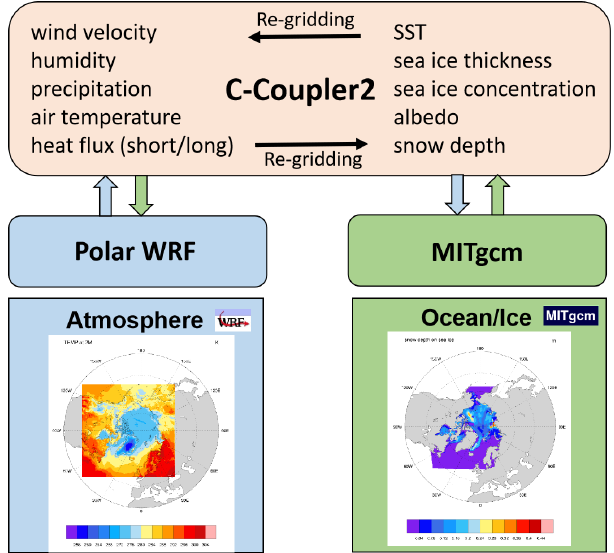
Figure 1. Coupling strategy of the Polar WRF-MITgcm coupled model system.